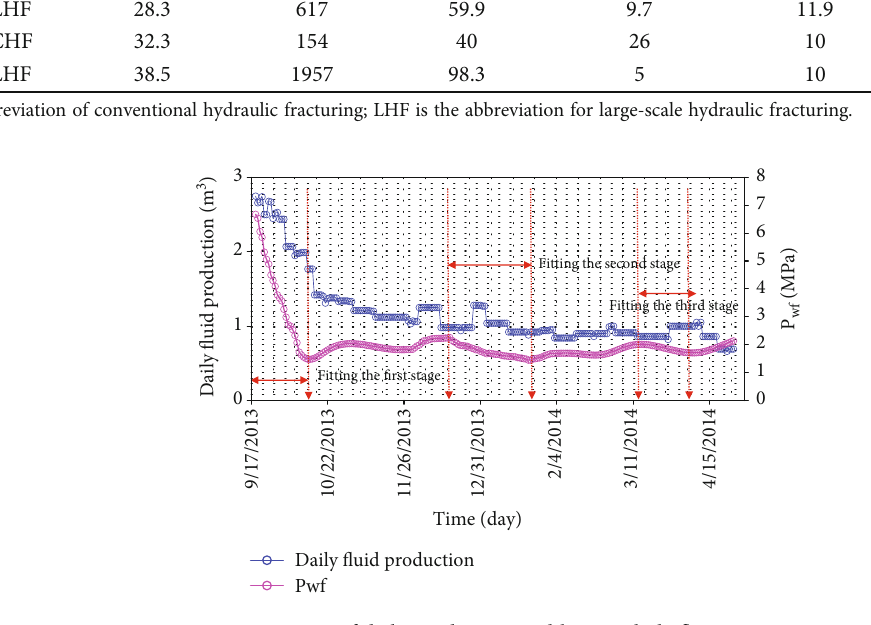
Figure 3: Data processing of daily production and bottom-hole fl ow pressure in C1 well.